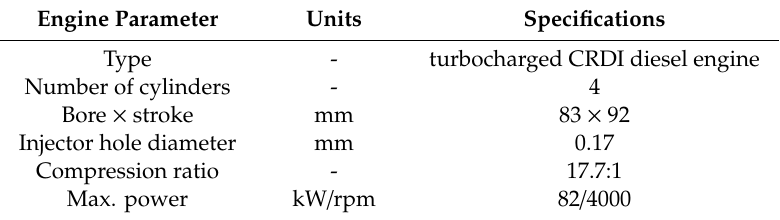
Table 2. Specifications of the test engine.